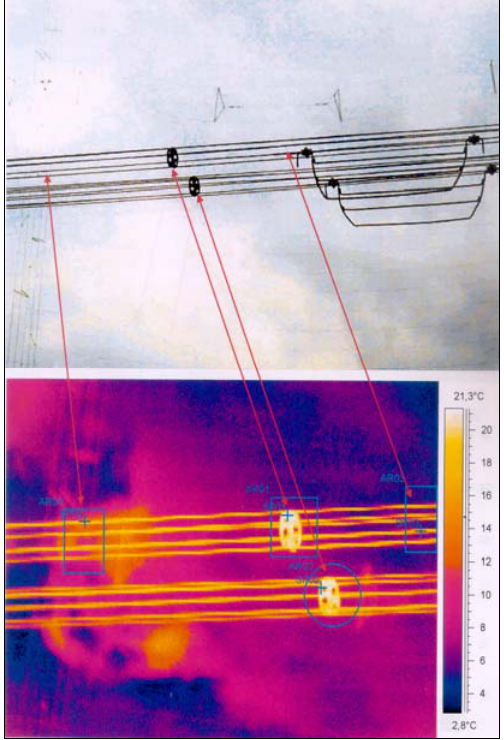
Fig 5. Thermogram of the junction feeder line – spacing collar, capacitor